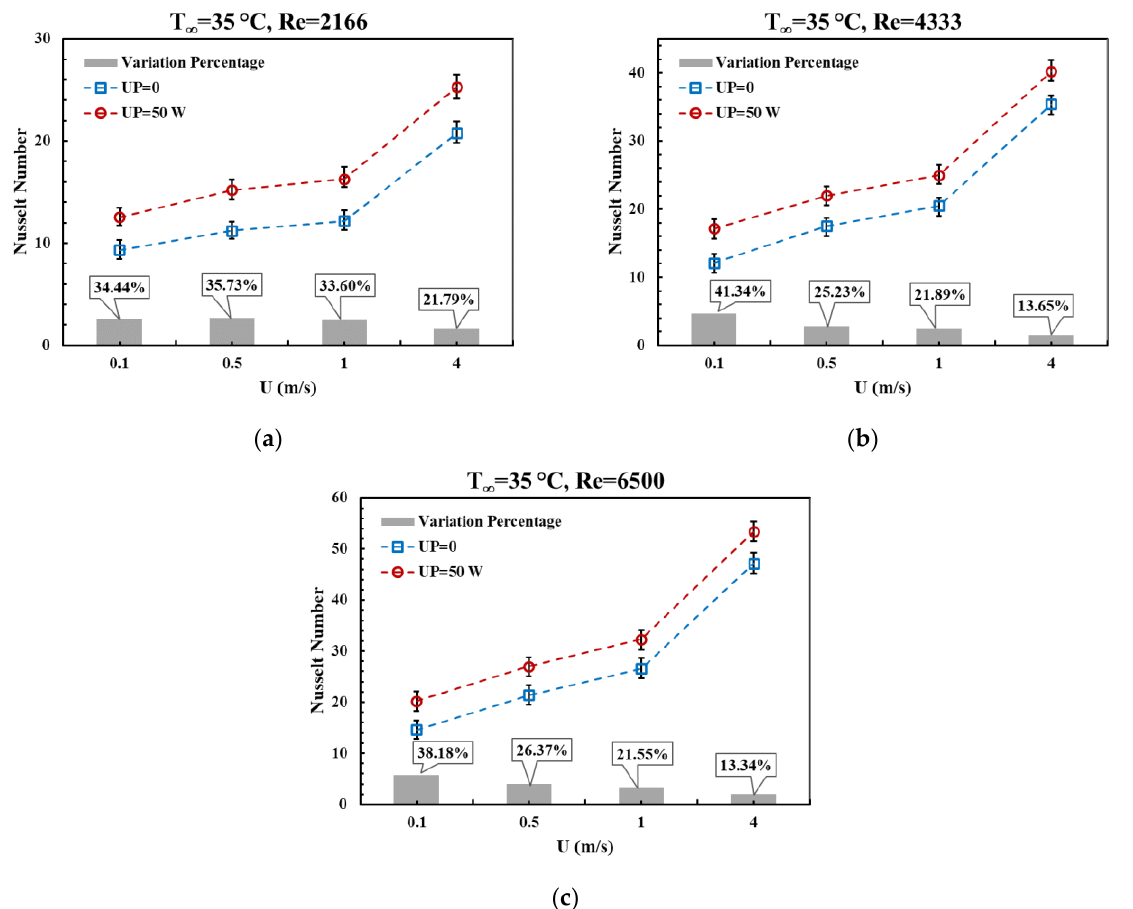
Figure 13. The variations of Nusselt number against 𝑈 at 𝑇 ∞ = 35 (°C) and Reynolds numbers of ( a ) Re = 2166, ( b ) Re = 4333, and ( c ) Re = 6500. The results are presented in a no-vibration state (UP = 0) and in the presence of vibration with ultrasonic power of 50 Watts (UP = 50 (W)).